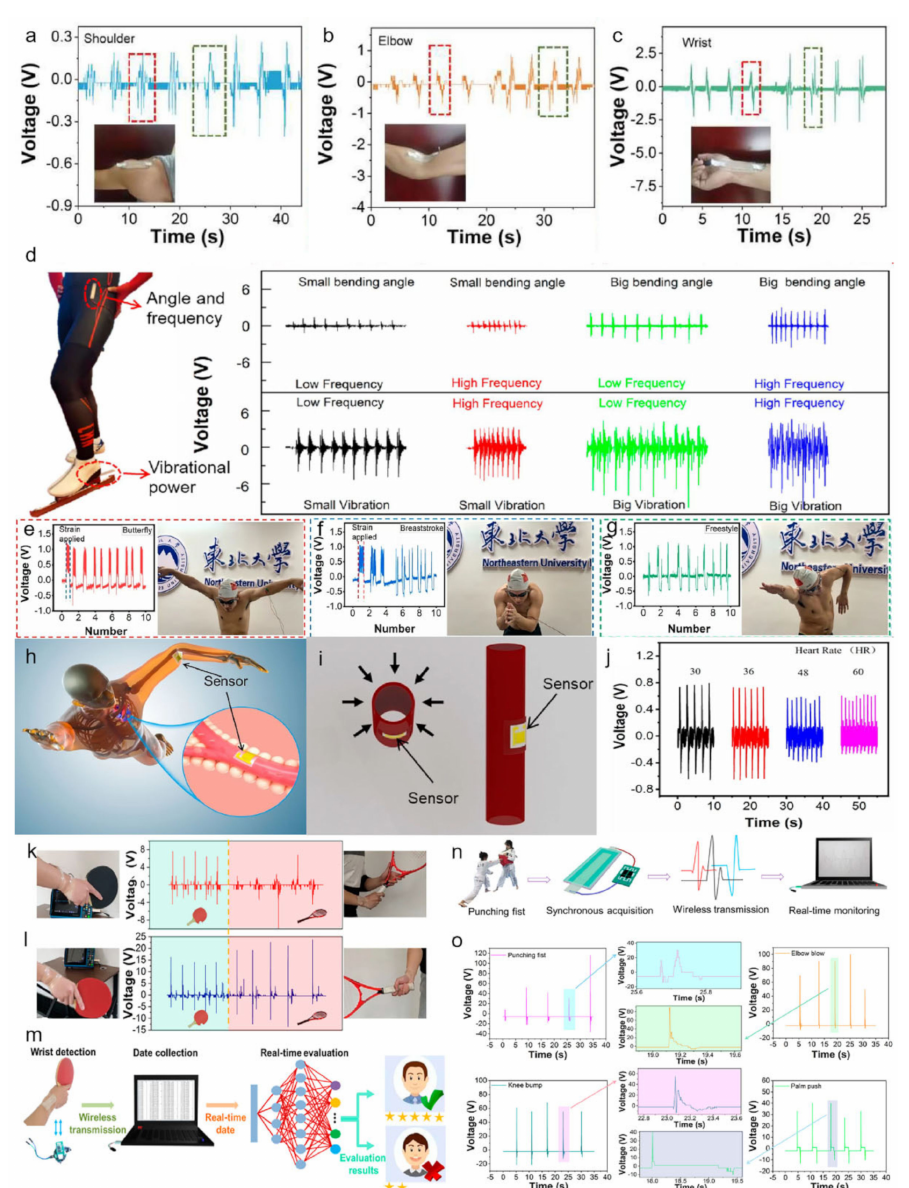
Figure 4. ( a ) Outputting piezoelectric voltage of TSB-PENG on the shoulder that does the bend and stretch motion. ( b ) Outputting piezoelectric voltage of TSB-PENG is fixed on the elbow which protrudes, bends, and stretches. ( c ) Outputting piezoelectric voltage of TSB-PENG is fixed on the wrist that protrudes, bends, and stretches. ( a – c ) Reprinted with permission from Ref. [89]. ( d ) Output piezoelectric voltage of speed skating during four sport states. Reprinted with permission from Ref. [90]. ( e ) Output piezoelectric voltage of butterfly stroke. ( f ) Output piezoelectric voltage of breaststroke. ( g ) Output piezoelectric voltage of freestyle stroke. ( h ) Simulating the monitoring of athlete’s elbow joint angle and heart rate. ( i ) Simulation of arterial work and biosensor attachment position. ( j ) Output piezoelectric voltage of the arterial model monitored by biosensor. ( e – j ) Reprinted with permission from Ref. [91]. ( k ) The output voltage of the canonical table tennis attack technique with tennis swing action. ( l ) The output voltage of the incorrect table tennis attack technique and tennis swing action. ( m ) The working process of wireless intelligent motion error correction system. ( k – m ) Reprinted with permission from Ref. [92]. ( n ) Unsportsmanlike action monitoring system. ( o ) Voltage and waveform generated by punching, elbow blow, knee bump, and palm push. ( n , o ) Reprinted with permission from Ref.